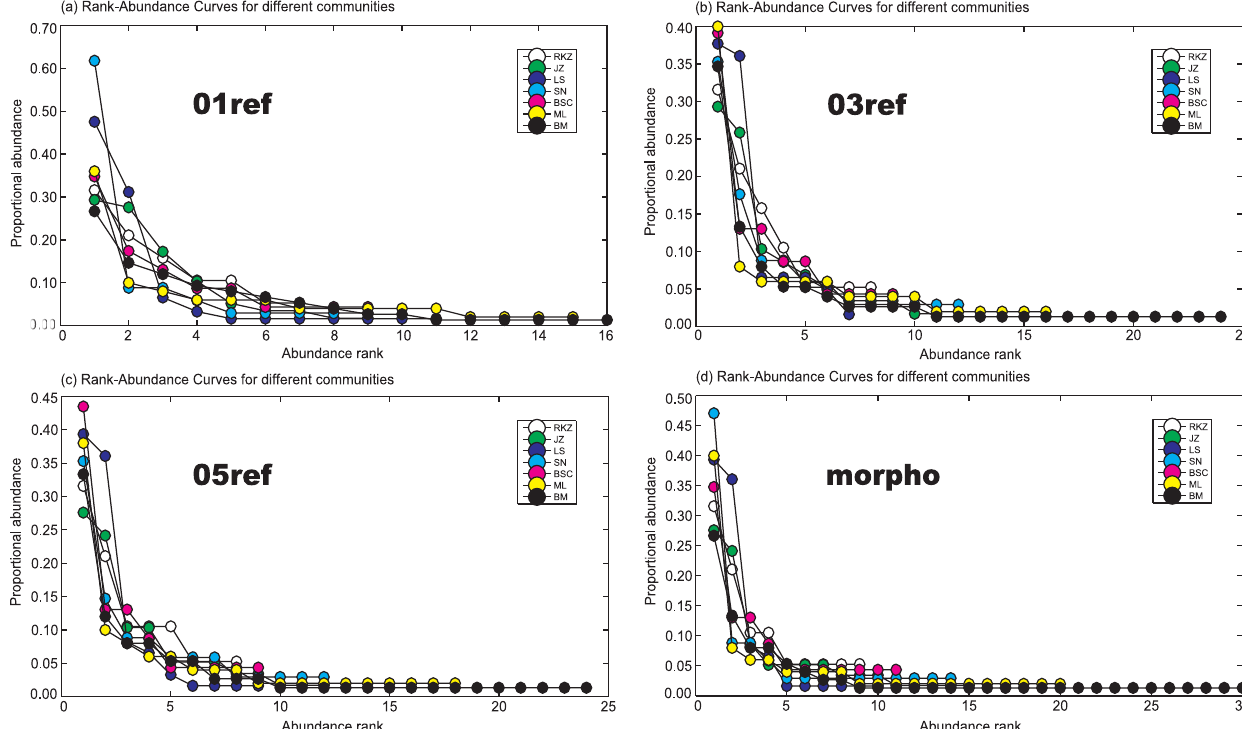
Figure 3. Rank-abundance curves of each community based on DNA barcoding (DB) with different reference database (a–c) or traditional morphology (TM) (d). (a) DB-based rank-abundance curves for each community based on reference size of 10% (01 ref). (b) DB-based rank-abundance curves for each community based on a reference size of 30% (03 ref). (c) DB-based rank-abundance curves for each community based on a reference size of 50% (05 ref). (d) TM-based rank-abundance curves for each community.